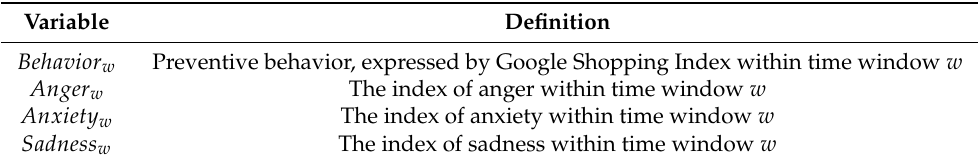
Table 4. Definition of variables.